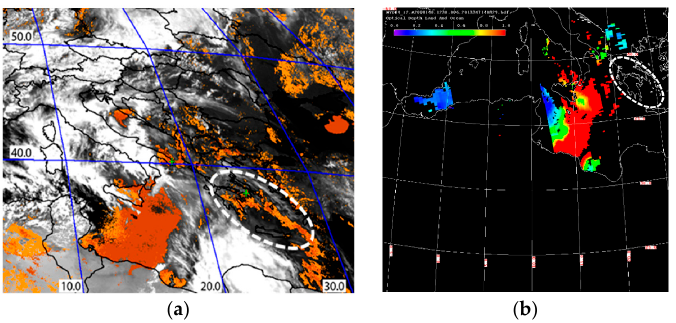
Figure 4. ( a ) e RST DUST map of 19 May 2008 at 12:30 UTC with the indication of regions characterized by a high (brown pixels) and medium-low (orange pixels) probability of dust presence in the atmosphere; ( b ) Aqua-MODIS AOD at the 550 nm product (Level-2) of the same day and hour. The white ellipse indicates a dusty region detected by e RST DUST that was not quantified in terms of AOD. Green crosses indicate location of Lecce-University (Southern Italy) and Athens (Greece) AERONET stations (see text).